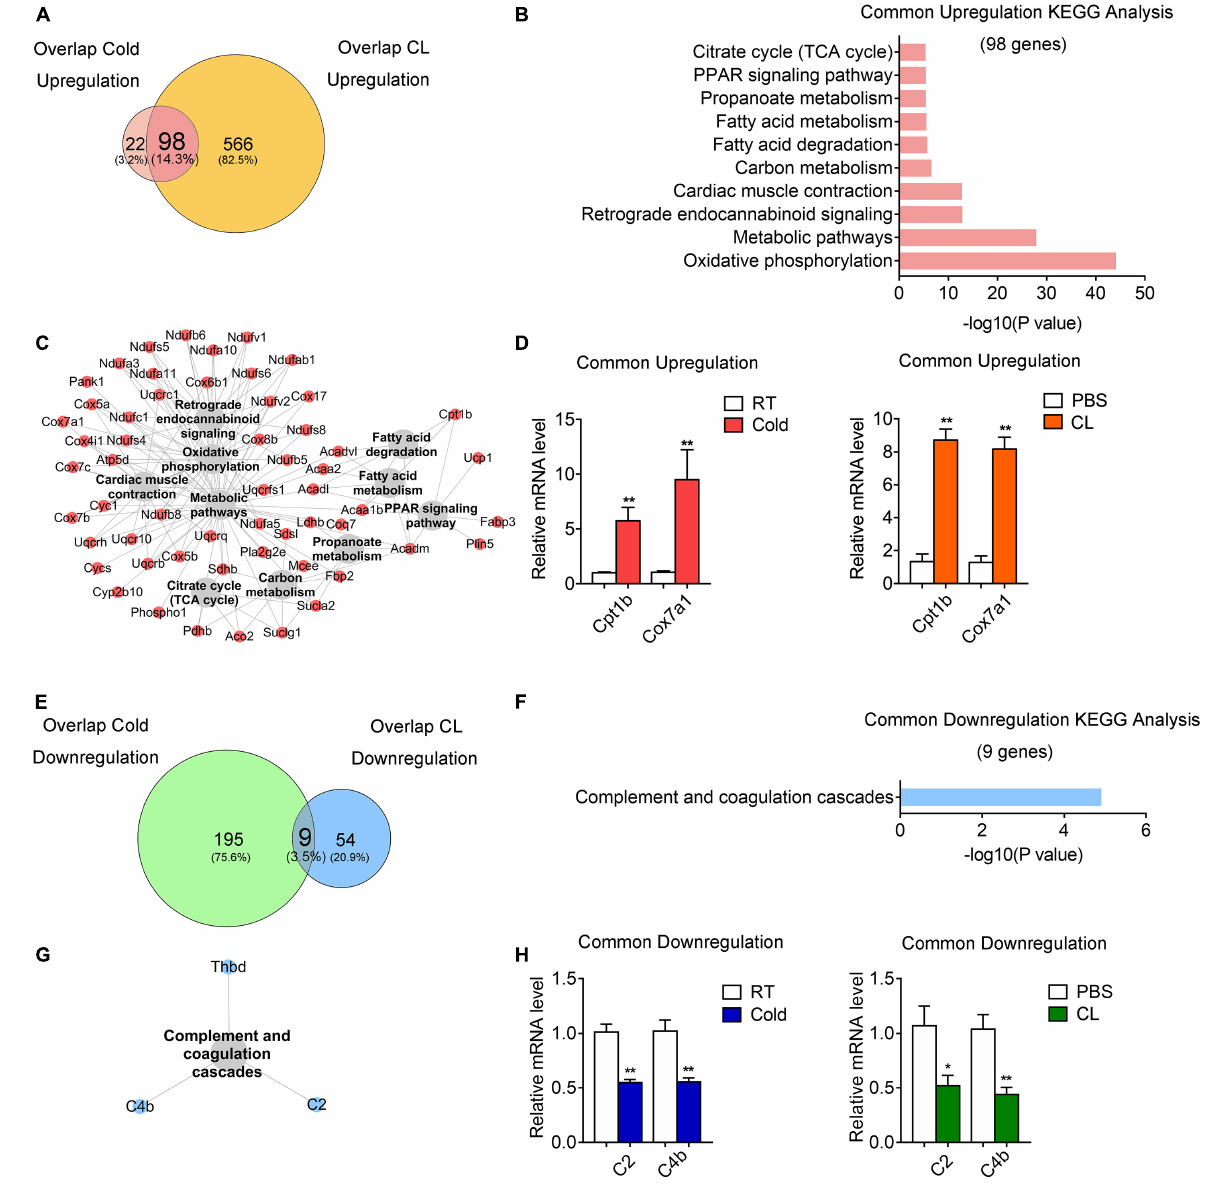
FIGURE 6 | Comparative analysis of commonly regulated genes by cold and CL exposure. Analysis of overlapped DEGs between cold (commonly regulated genes from GSE86338 and GSE164219 datasets) and CL (commonly regulated genes from GSE86338 and GSE129083 datasets). (A,E) Venn diagrams for commonly upregulated (A) and downregulated (E) DEGs between cold and CL treatment. (B,C,F,G) KEGG analysis and pathway-gene network for the upregulated 98 genes (B,C) shown in (A) and downregulated 9 genes (F,G) shown in (E) . (D,H) mRNA levels of top ranked upregulated (D) genes from (A) and downregulated (H) genes from (E) . N = 6 per group. Data are presented as mean ± SEM and * P < 0.05, ** P < 0.01 compared to control